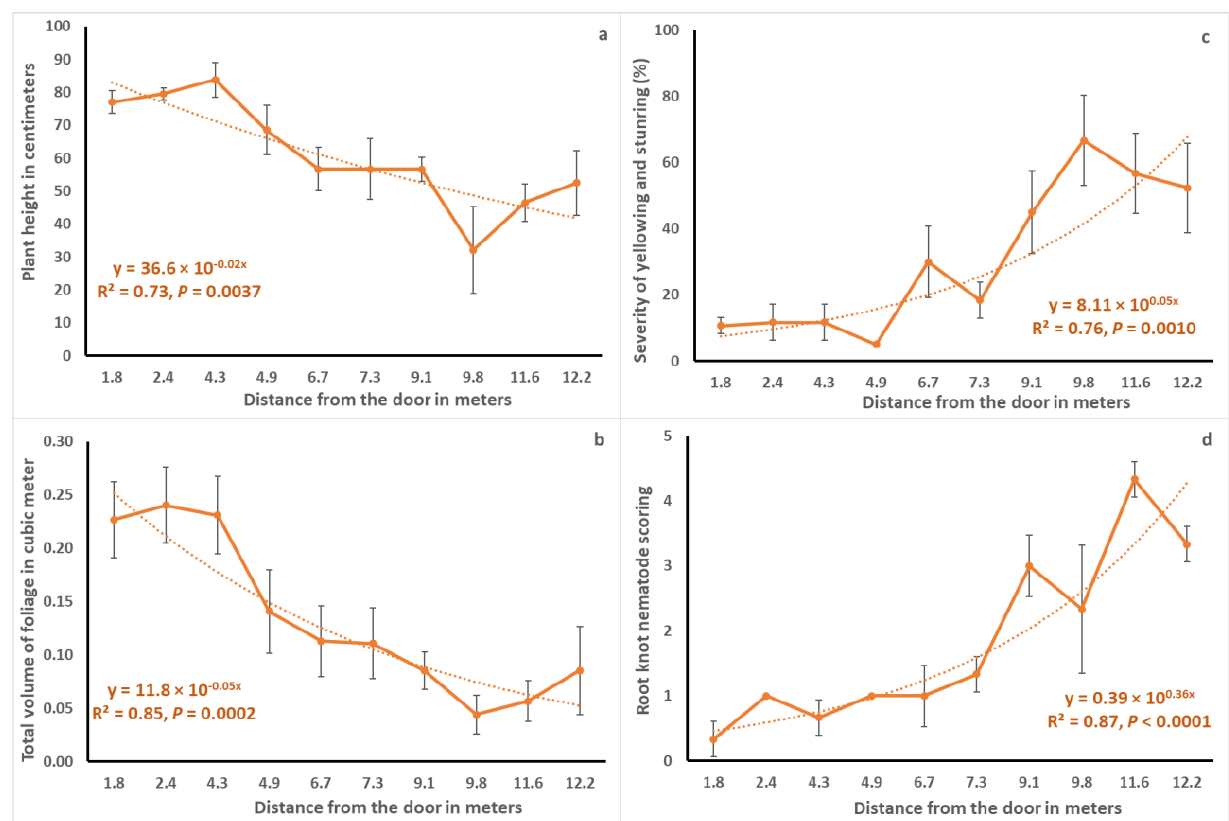
Figure 4. Spatial pattern of growth parameters (left) in terms of ( a ) plant height (cm) and ( b ) total volume of foliage (cubic meters) and ginger plant health parameters (right) in terms of ( c ) disease severity (%) and ( d ) root knot nematode rating (0–5) following Zecks’s [31] scale as one walks from the door to the back of the high tunnel. The continuous lines are the actual data points and the dotted lines represent predicted data according to the exponential function.